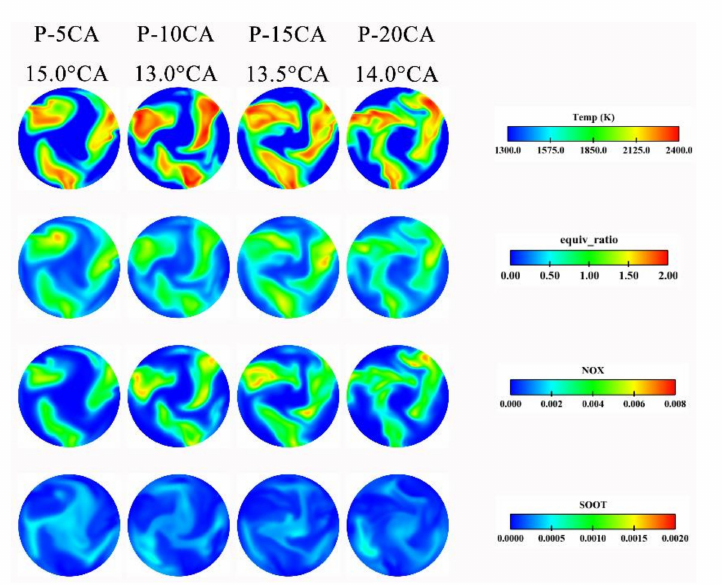
Figure 15. Impact of pilot injection timing on the distribution of temperature, fuel-air equivalence ratio, NOx formation, and soot formation at the moment of q90 for various injection